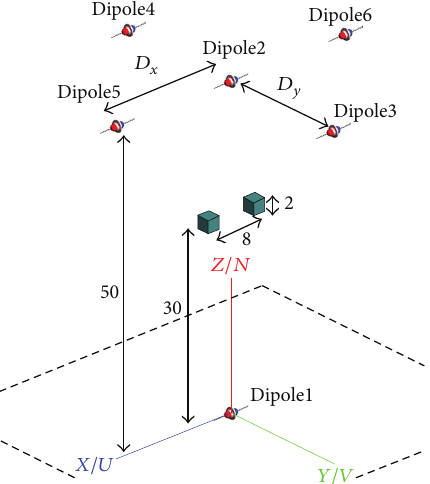
Figure 4: Simulation example in FEKO. All dimensions are in mm. Thebackgroundhaspropertiesof 𝜀 b 𝑟 = 16 and 𝜎 is performed for two objects along the 𝑥 axis with properties 𝜀 o 𝑟 = 32 = 1 and 𝜎 o